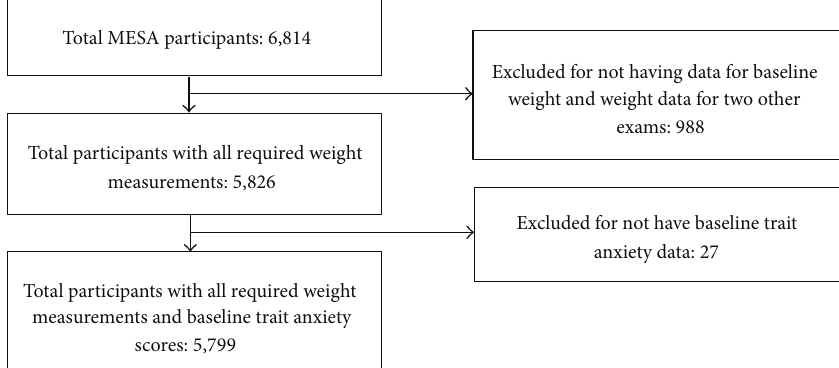
Figure 1: Flow chart of participant exclusion.